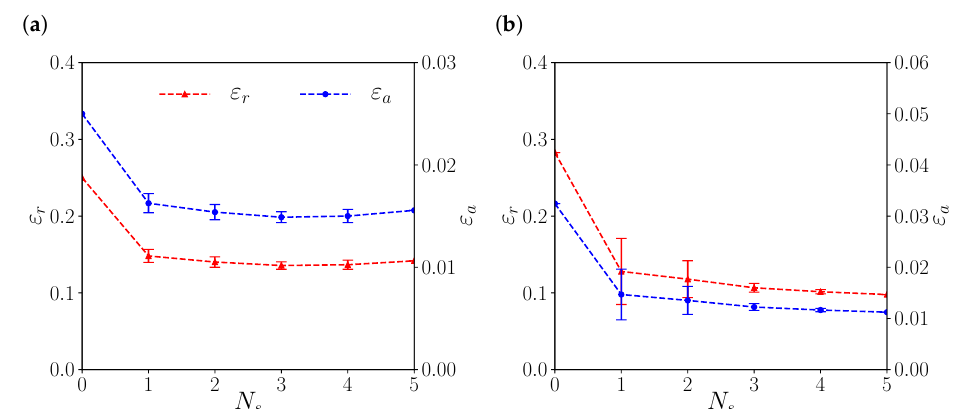
Figure 12. Mean absolute ( ε a ) and relative ( ε r ) errors against the number of sidewall vortex sheets, N s , for θ = 45°: ( a ) u x ; ( b ) u y . The error bars represent the minimum and maximum errors for each ensemble of N s sidewall vortex sheets. absolute errors are represented by blue lines; relative ones are denoted by red lines.